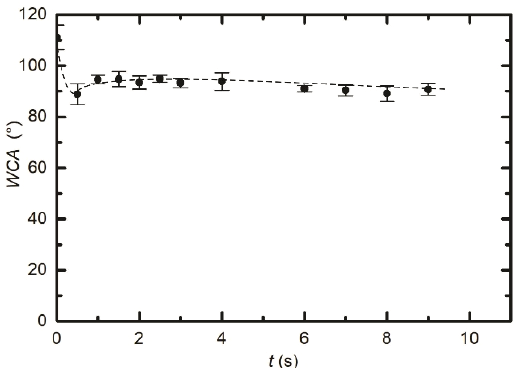
Figure 3. Variation of surface wettability with treatment time. The samples were inside the radiofrequency (RF) coil. Discharge power and hydrogen pressure were constant at 400 W and 25 Pa, respectively.